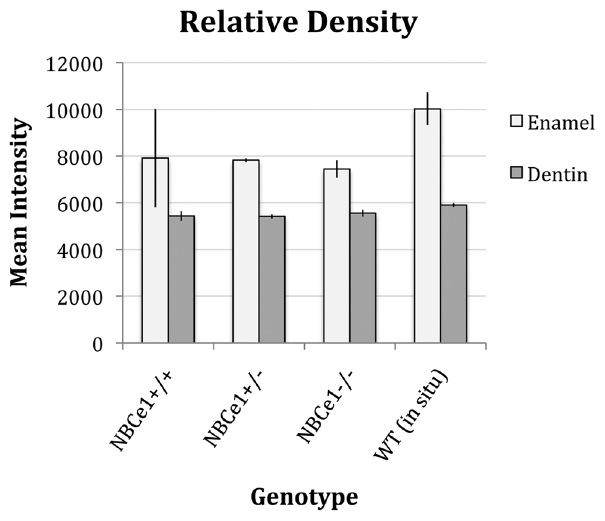
Figure 3. Enamel and dentin relative density measurements. The densities of teeth grown in the host kidney capsule, indicated by mean intensity value from m CT scanning, were compared across NBCe1 + / + , NBCe1 + / 2 and NBCe1 + / 2 groups. Teeth imaged and used for analysis were NBCe1 + / + (n=5), NBCe1 + / 2 (n=3) and NBCe1 2 / 2 (n=5). The averages and standard deviations (error bars) were plotted. Two- tailed Student’s t tests were run and no statistically significant difference in either enamel or dentin density was identified between any of the groupings. Refer to Table 1 for raw